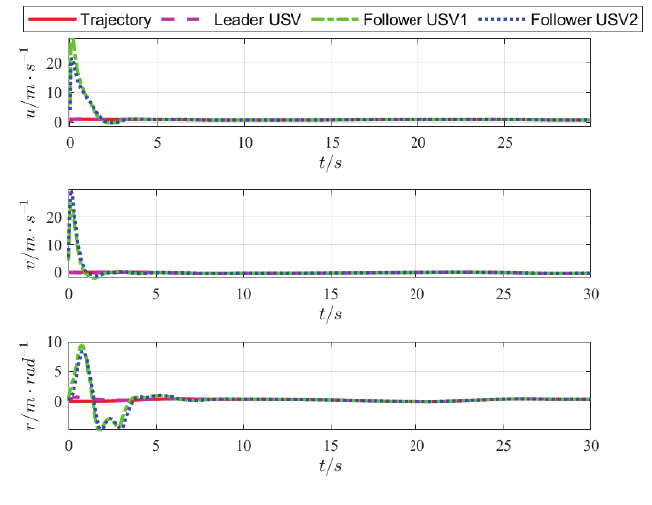
Figure 9. Velocity tracking using fixed-time control.